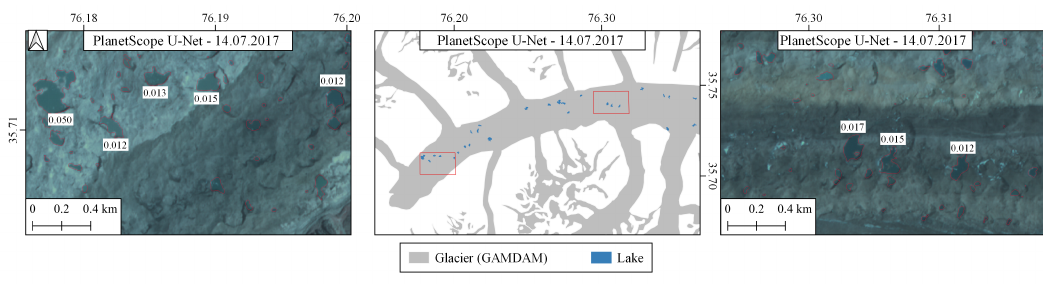
Figure 12. Two areas over Baltoro glaciers are shown in detail along lake sizes (for lakes with area > 0.01km 2 ). Keeping in view the uncertainty in the lake area estimation, some of these lakes have area close to 0.01km 2 , which is often used as the minimum mapping area for glacial